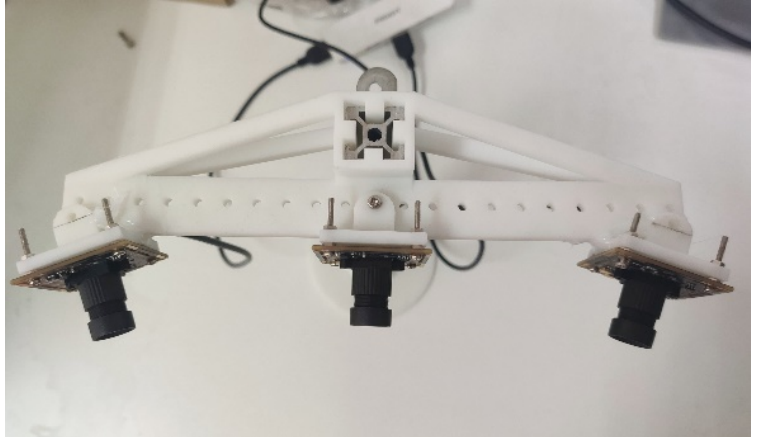
Figure 4. Image acquisition platform.